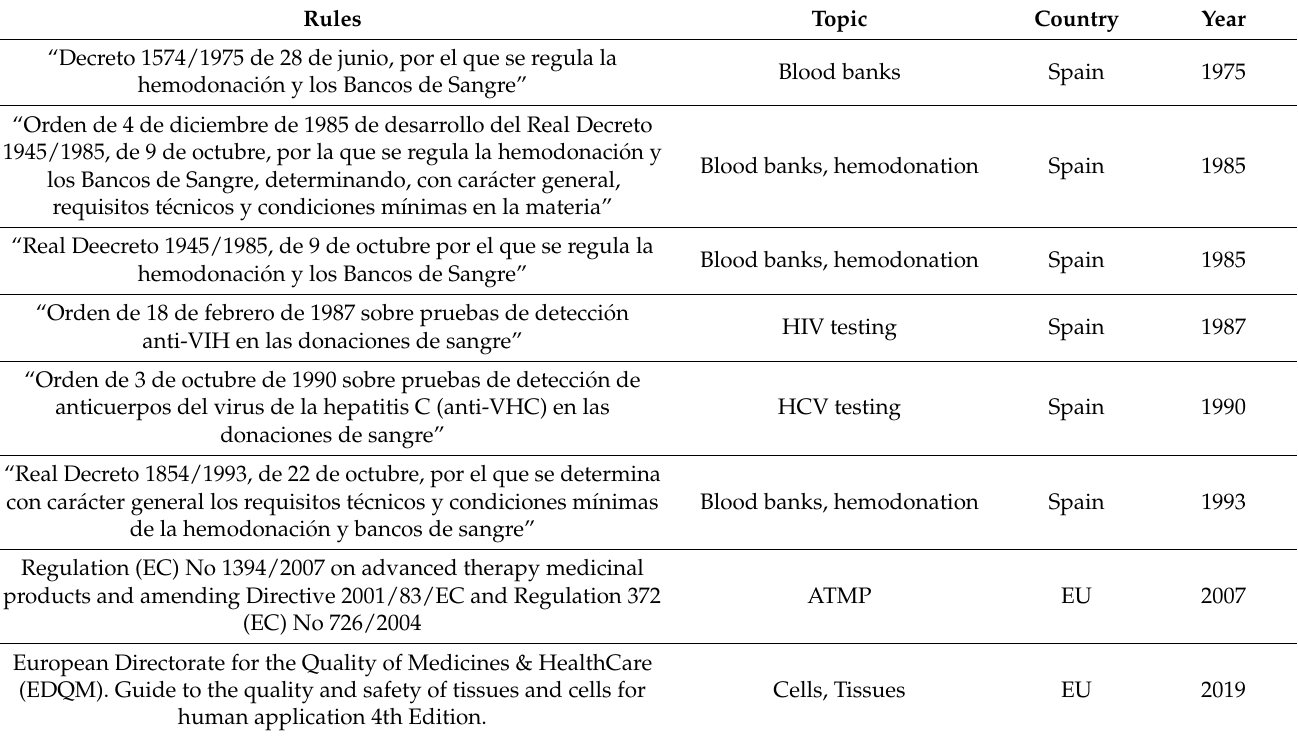
Table 1. Applicable laws and guidelines in the evolution of cell therapy quality management systems in